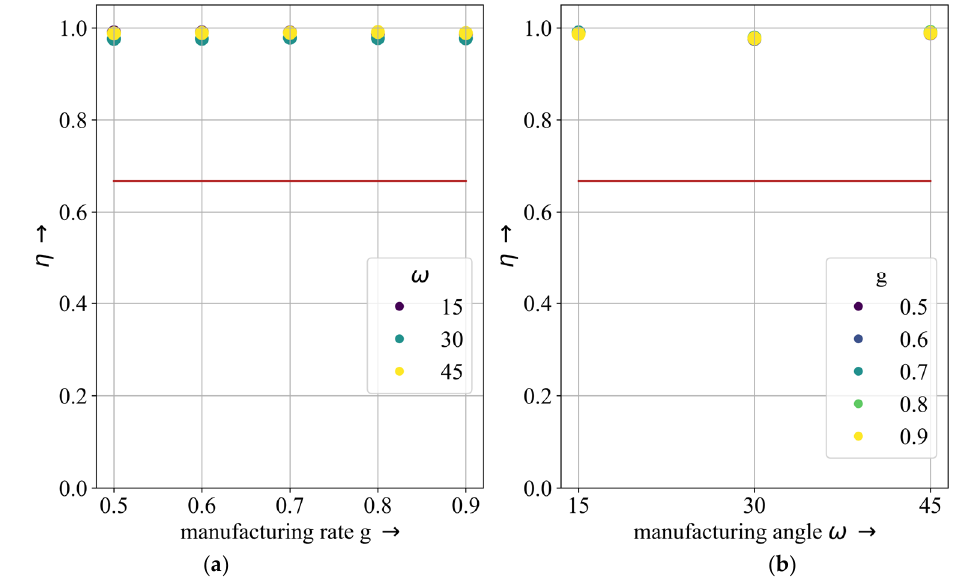
Figure 9. The effective material usage of the bracket design proposals. The red line indicates η of the reference design proposal. ( a ) Shows the effective material usage η as a function of manufacturing rate g; ( b ) Shows the effective material usage η as a function of manufacturing angle ω . For the bracket, all settings led to a η of minimum 98%.